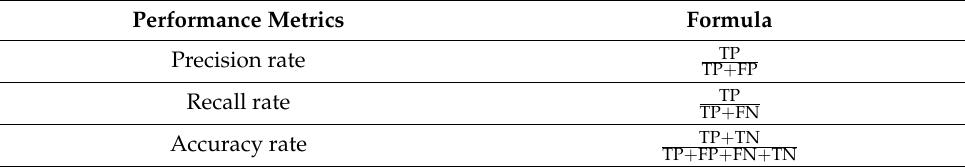
Table 4. Performance evaluation index and calculation formulas.